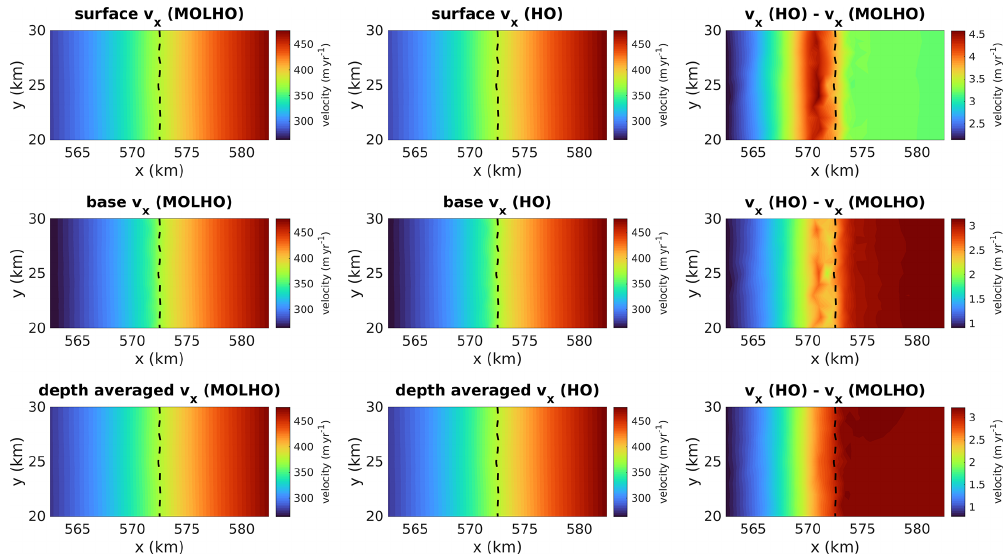
Figure 7. Comparison of ice velocities in the x direction obtained with MOLHO and HO using the same glacier geometry (thickness and grounding line). The figure shows the velocities at the surface and base of the glacier as well as the depth-averaged velocities. The velocities are computed using the steady-state geometry obtained with the phase Stnd with the HO model and horizontal mesh resolution of 1km. Dashed lines are the grounding line positions.